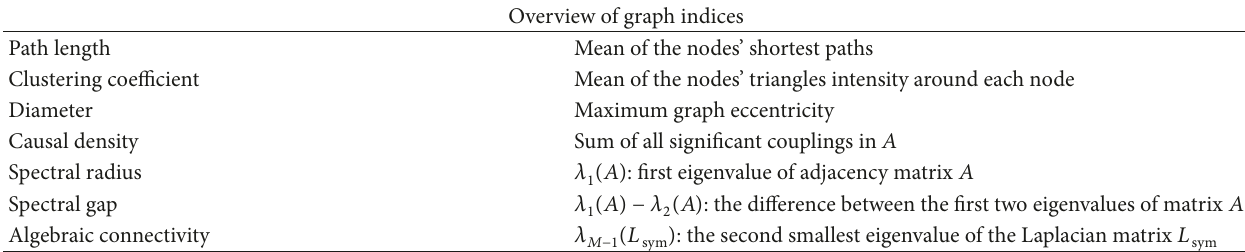
Table 1: An overview of all graph metrics that have been used in the